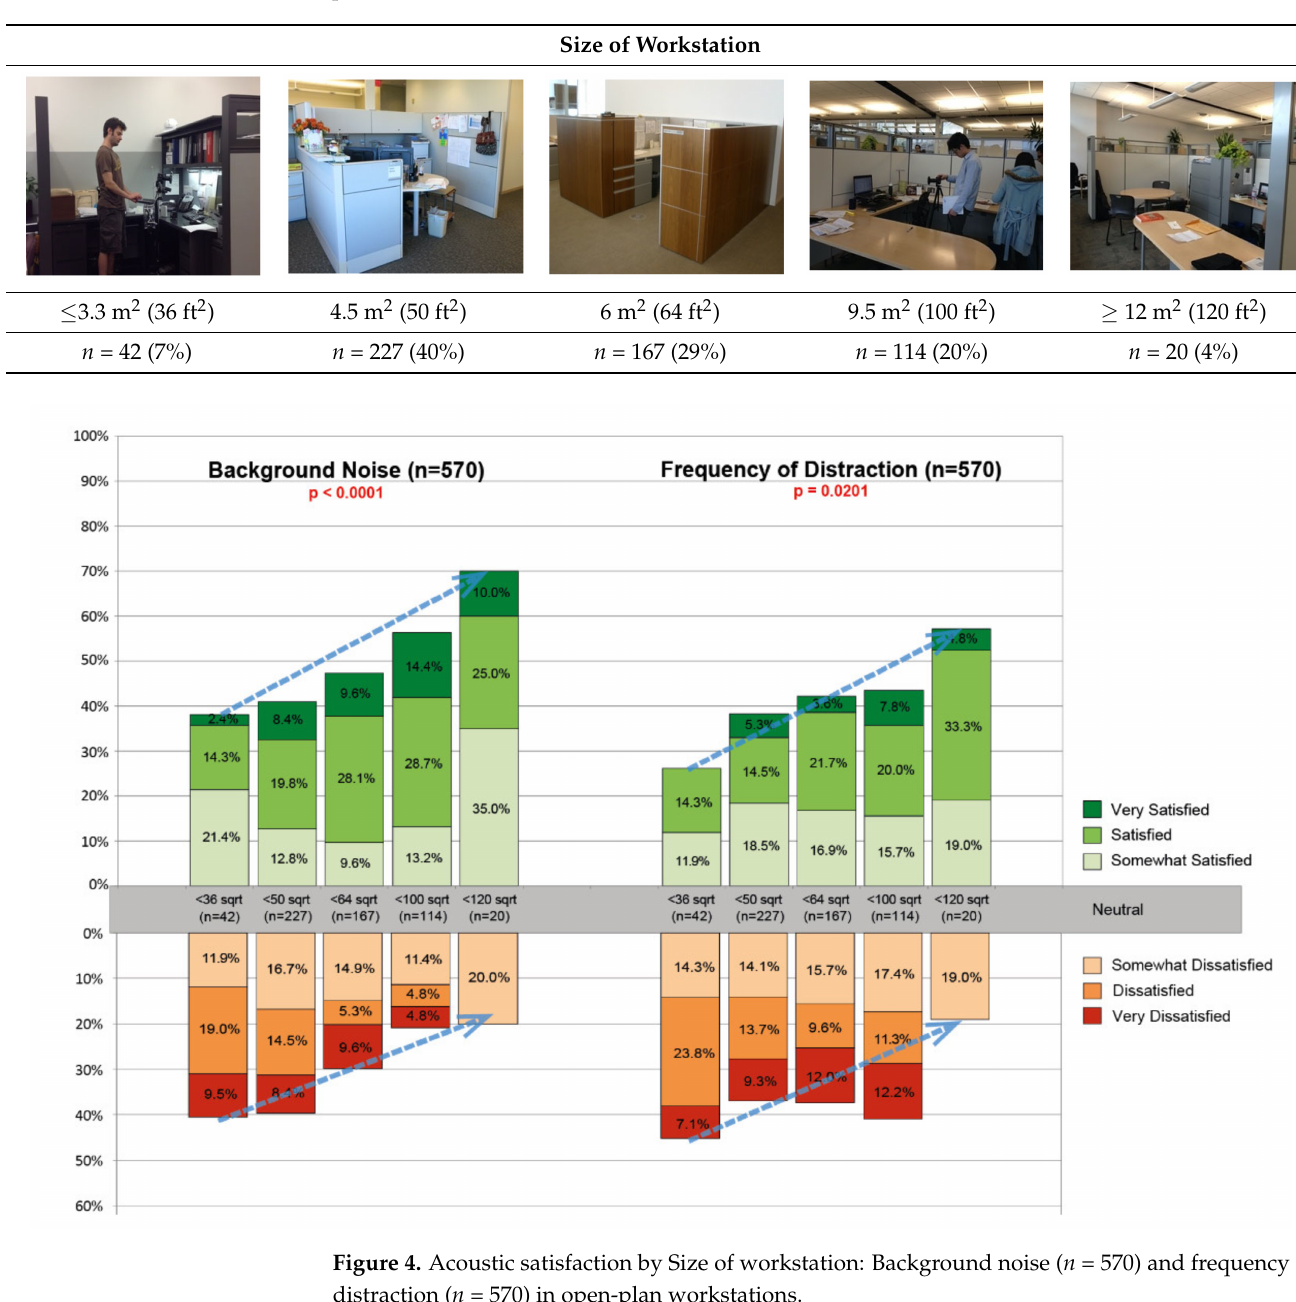
Table 11. Distribution in the Size of the Workstation for 570 Questionnaire respondents in open- plan workstations.